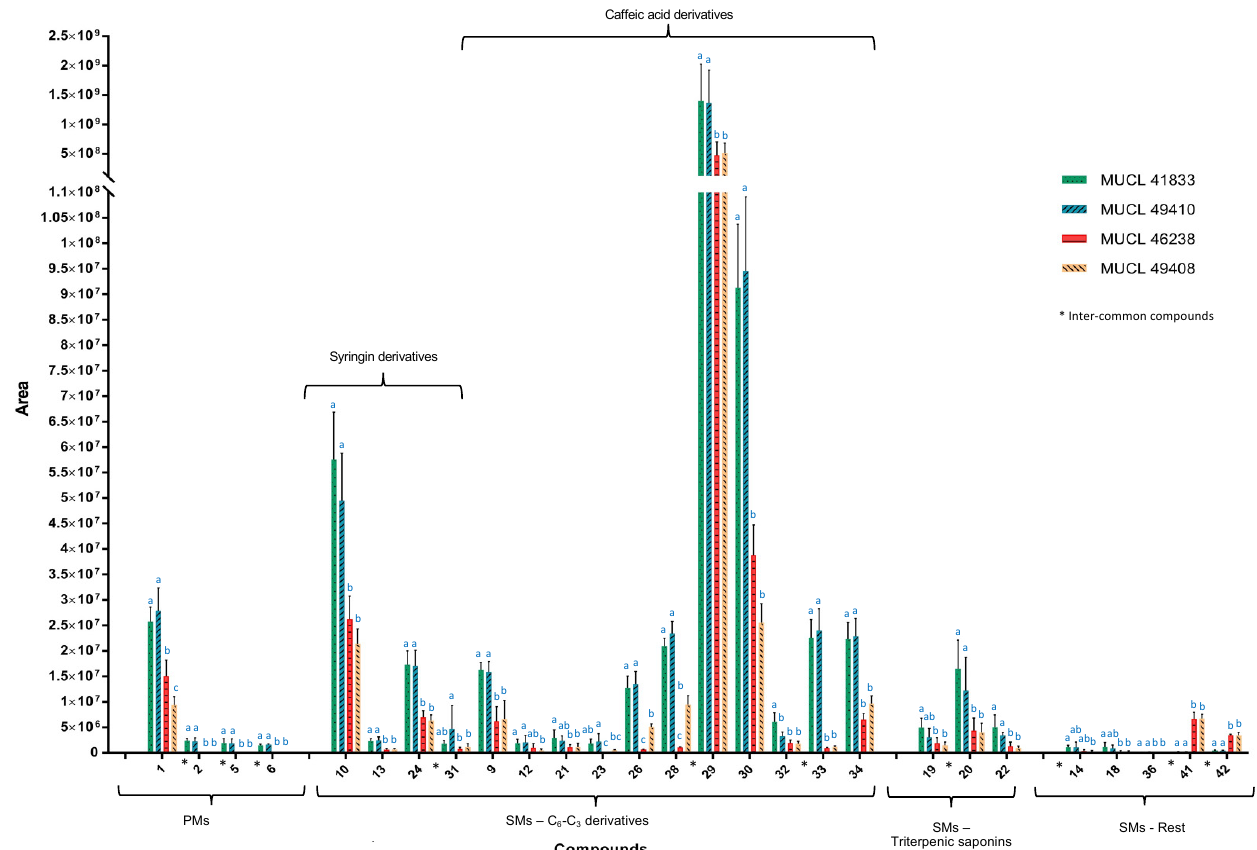
Figure 5. Graphical representation of metabolome profile variations in roots of Anchusa officinalis associated with four different AMF species ( R. irregularis MUCL 41883, R. intraradices MUCL 49410, R. clarus MUCL 46238 and R. aggregatus MUCL 49408). The AMF treatment means followed by the same lowercase letters are not significantly different according to HSD Tukey’s test ( p -value < 0.05).